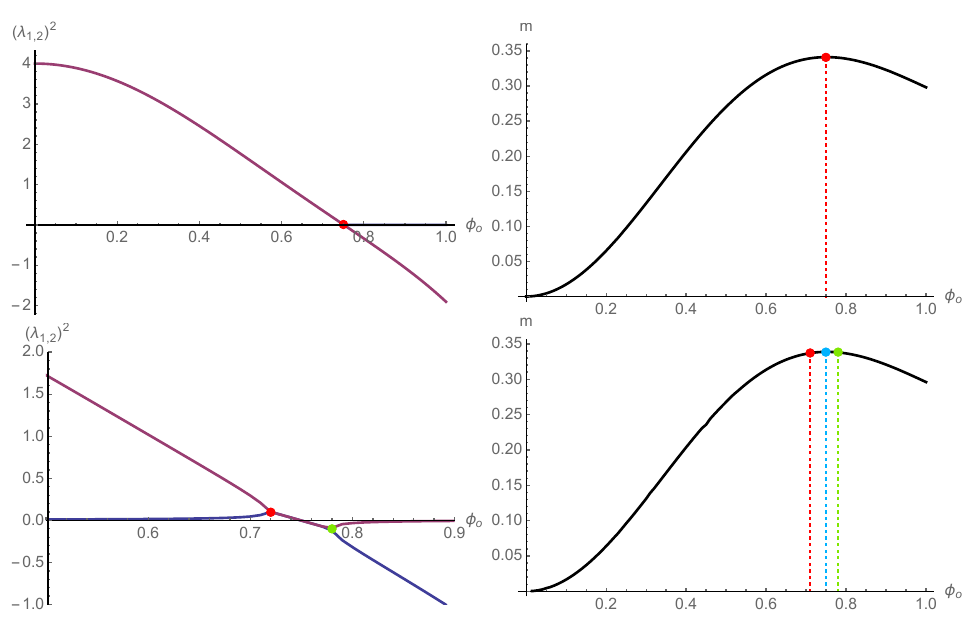
Figure 39 . Top: real part of the (cid:12)rst two squared eigenfrequencies of the lower Boson Star branch. The red point signals the onset of linear instability which corresponds to the maximum value attained by the mass along the same branch. Bottom: analogous plots for the (cid:30) s = (cid:0) : 001 sourced solution. The red point represents the onset of linear instability. Here the two lower eigenfrequencies meet and develop opposite complex parts. The instability (red dot) occurs before the maximum value of the mass along the branch is attained (light-blue